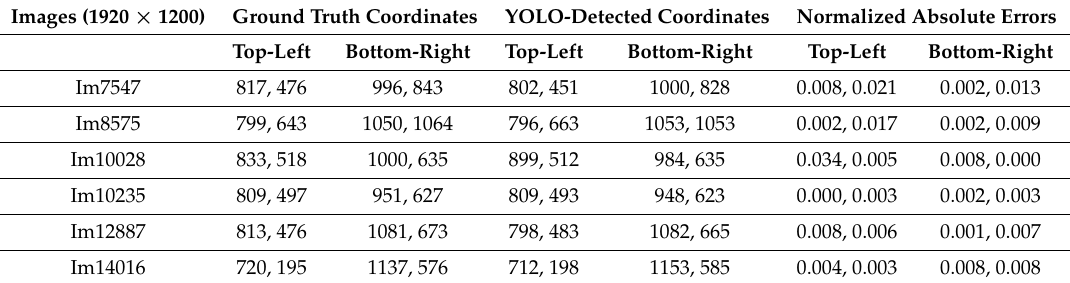
Table 3. YOLOv3 Performance in Spacecraft Detection and Bounding.